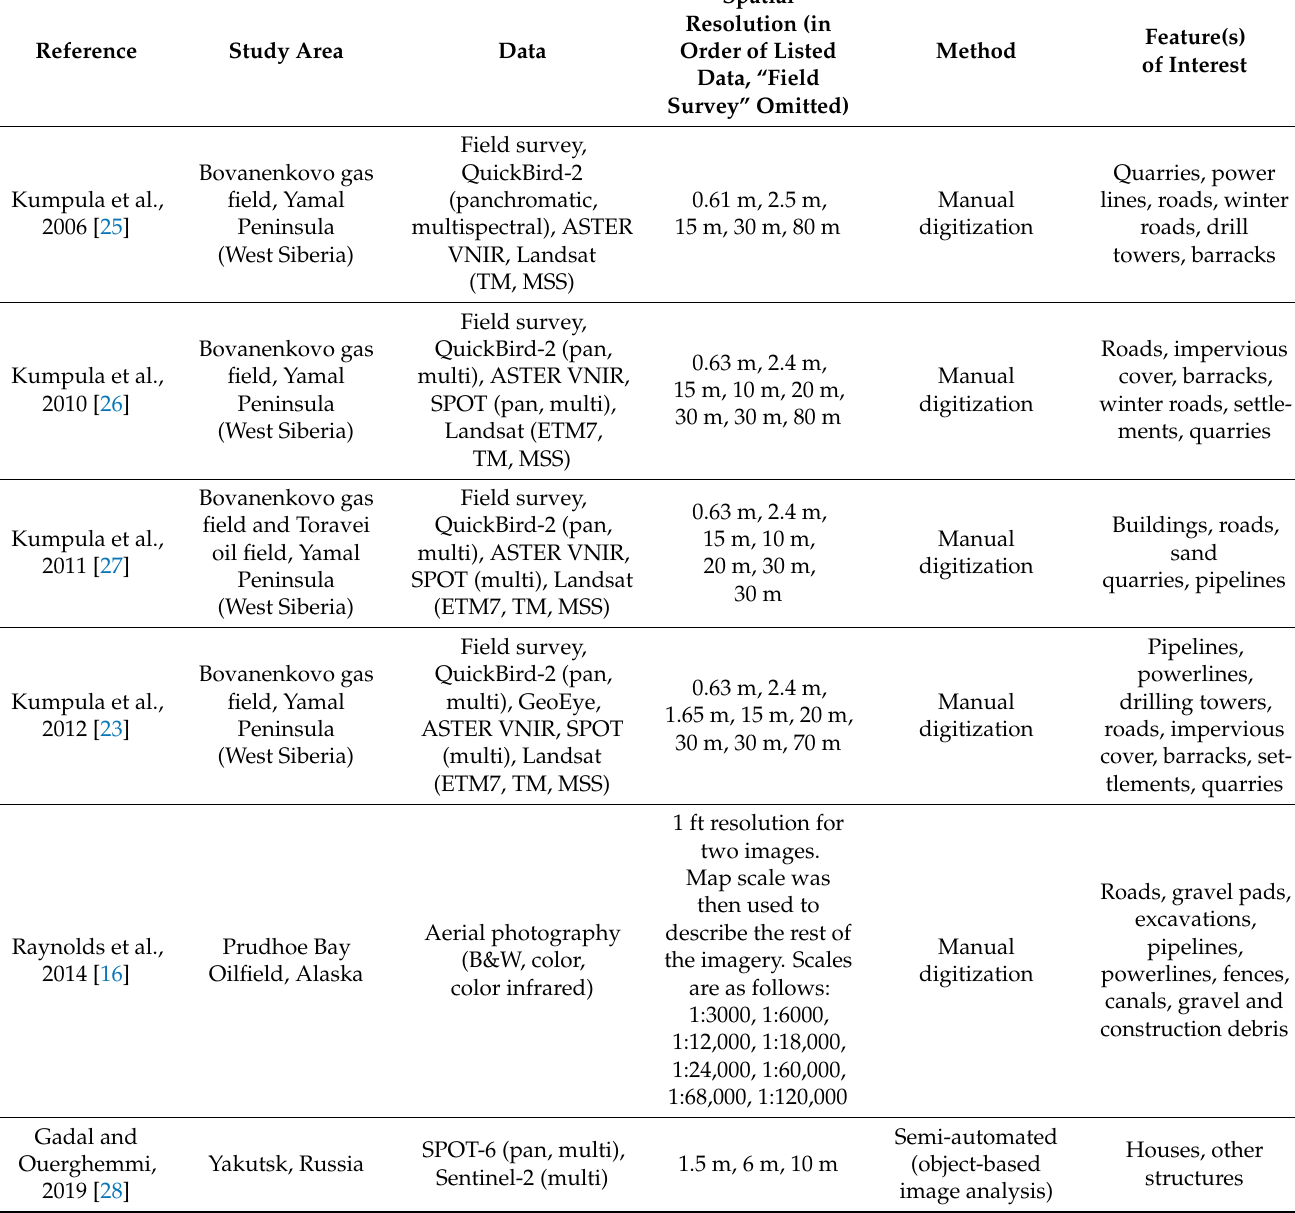
Table 1. Literature survey on satellite-based Arctic built infrastructure mapping